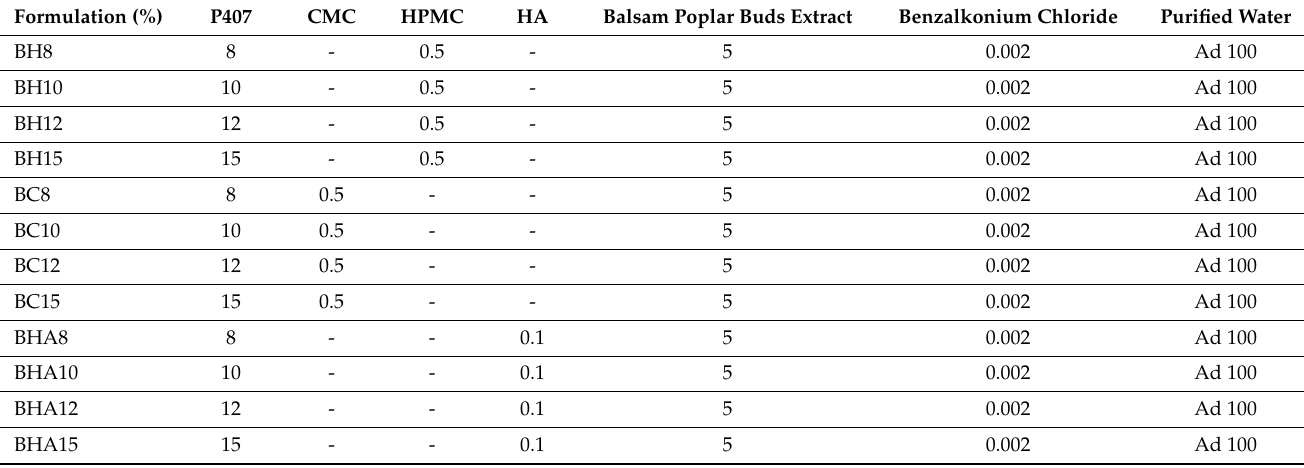
Table 2. Compositions of ophthalmic formulations with balsam poplar buds 30% aqueous PEG400